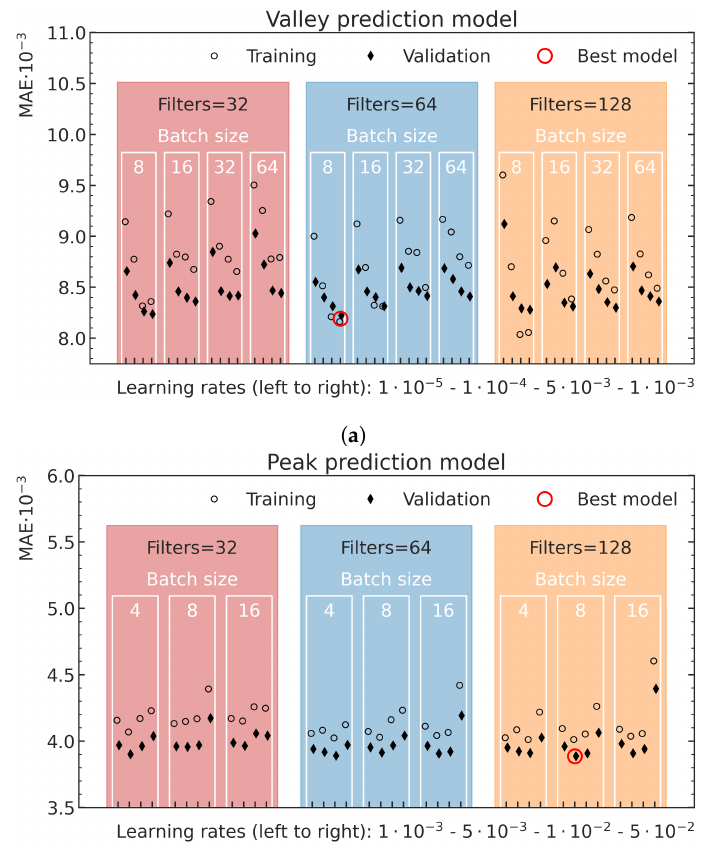
Figure 7. Overview of the validation loss values (diamonds) and the corresponding training data loss values (open circles) for different valley ( a ) and peak ( b ) energy deposition prediction model configurations. The x-ticks locate the different investigated learning rates, while the batch sizes and number of filters are highlighted for each model by their positioning in the respective white (batch size) and colored (number of filters) boxes. The best respective model is marked with a red